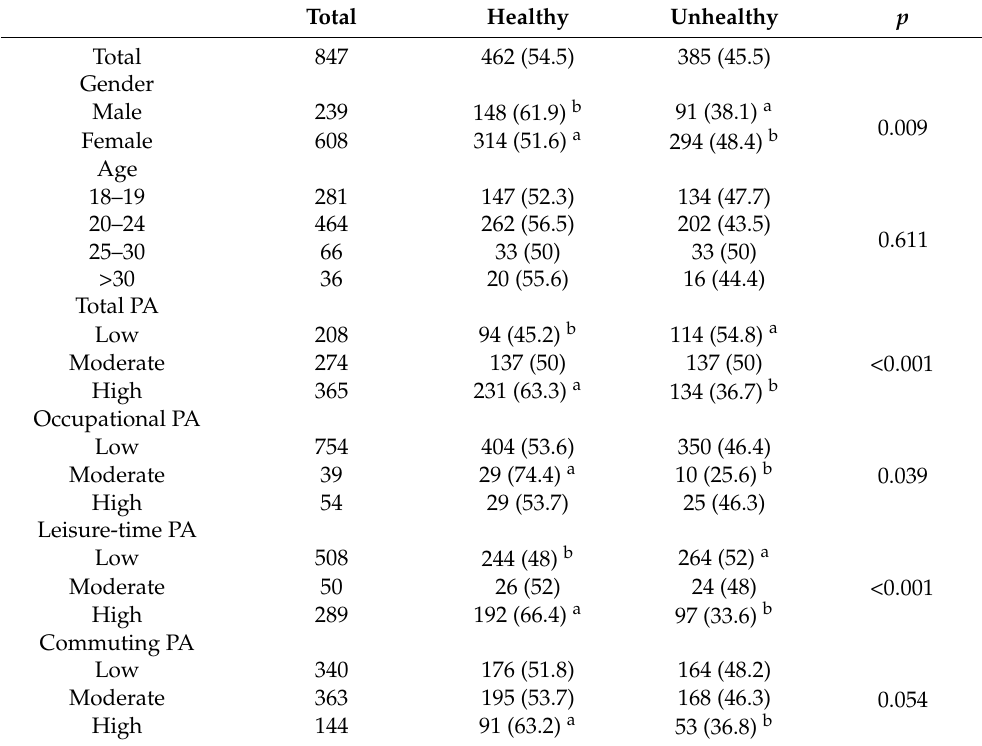
Table 2. Sample characteristics and distribution of healthy (GHQ12 < 4) and unhealthy (GHQ12 ≥ 4) mental